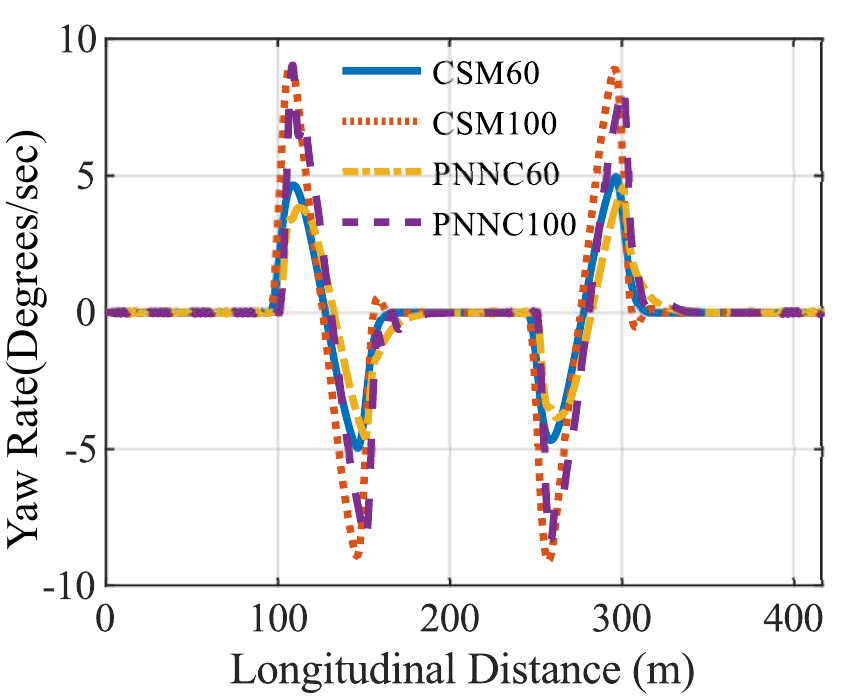
Figure 5. Yaw rate of the pure pursuit MPC controller (CSM) and the proposed Neural Network controller (PNNC) for v x = 60 km/h and v x = 100 km/h.